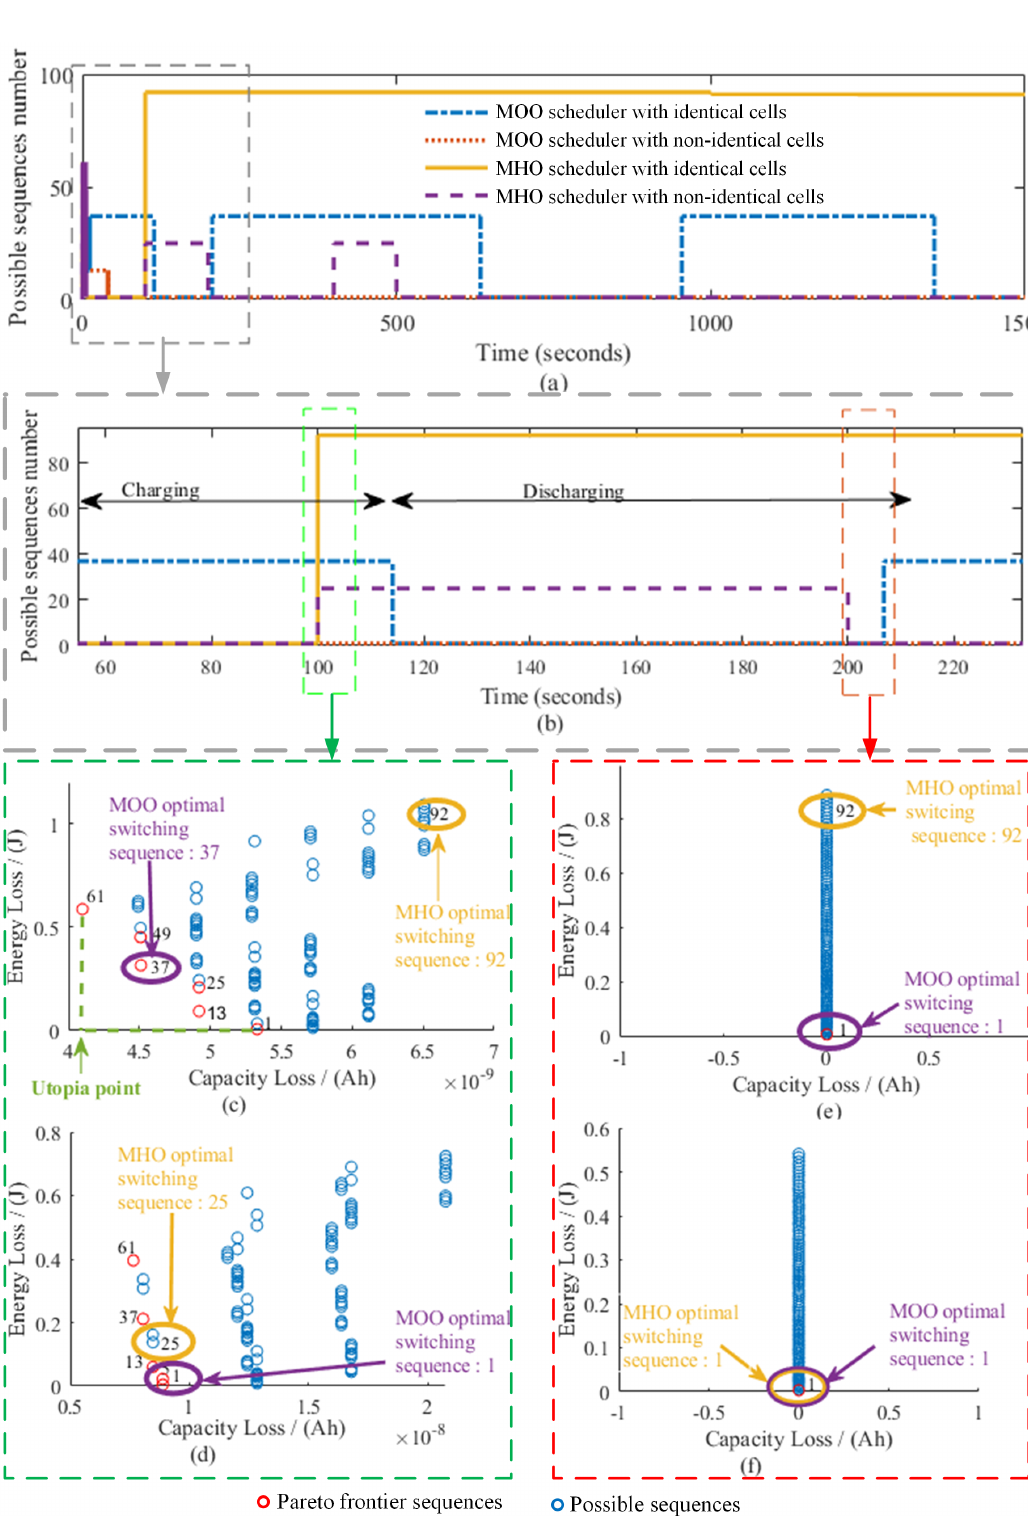
Figure 14. ( a ) Sequence change over a selected time of operation for the MOO- and MHO-based sched- ulers in the presence of identical and nonidentical cells. ( b ) An extraction of the same ( c ). Pareto analysis for identical cells under charging at t = 108 s. ( d ) Nonidentical cells under charging at t = 108 s. ( e ) Pareto analysis for identical cells under discharging at t = 200 s. ( f ) Nonidentical cells under discharging at t = 200